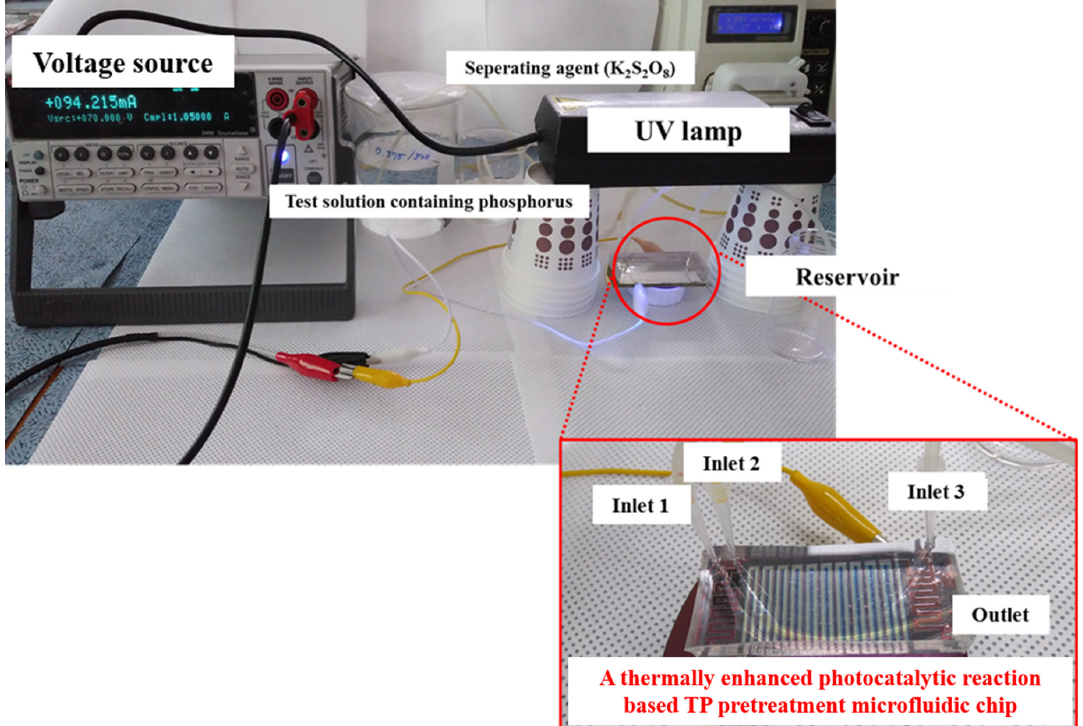
Figure 7. Experimental setup to estimate the proposed TP pretreatment microfluidic chip.